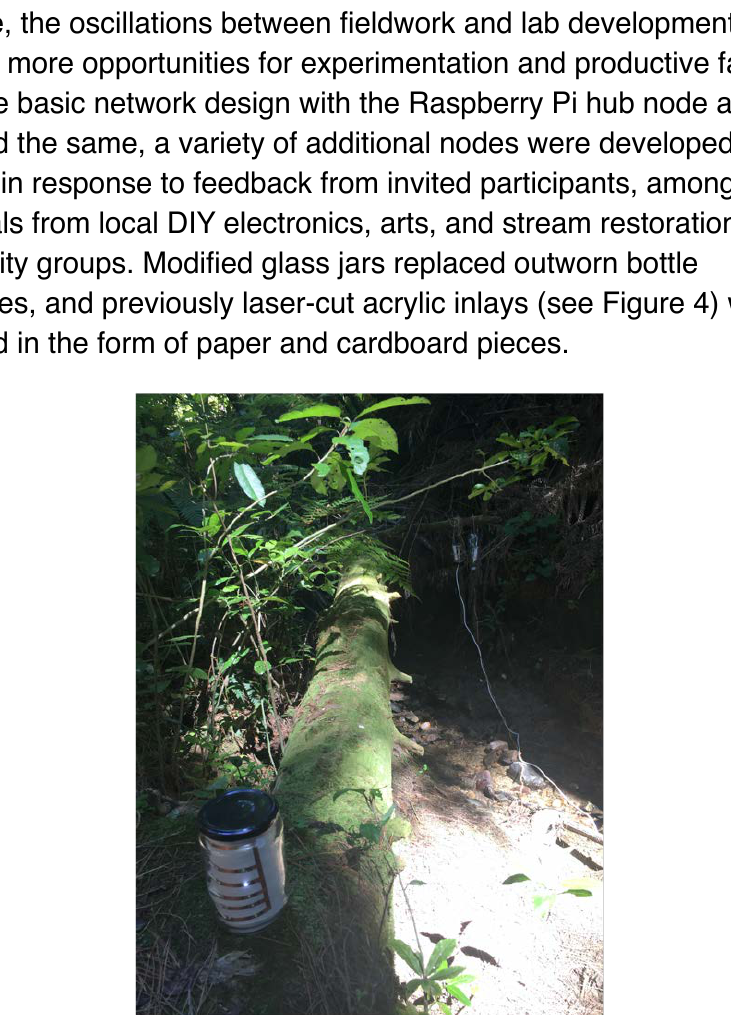
Figure 6: Papawai Stream installation showing visualisation node for electric conductivity in the front and sensors installed in the